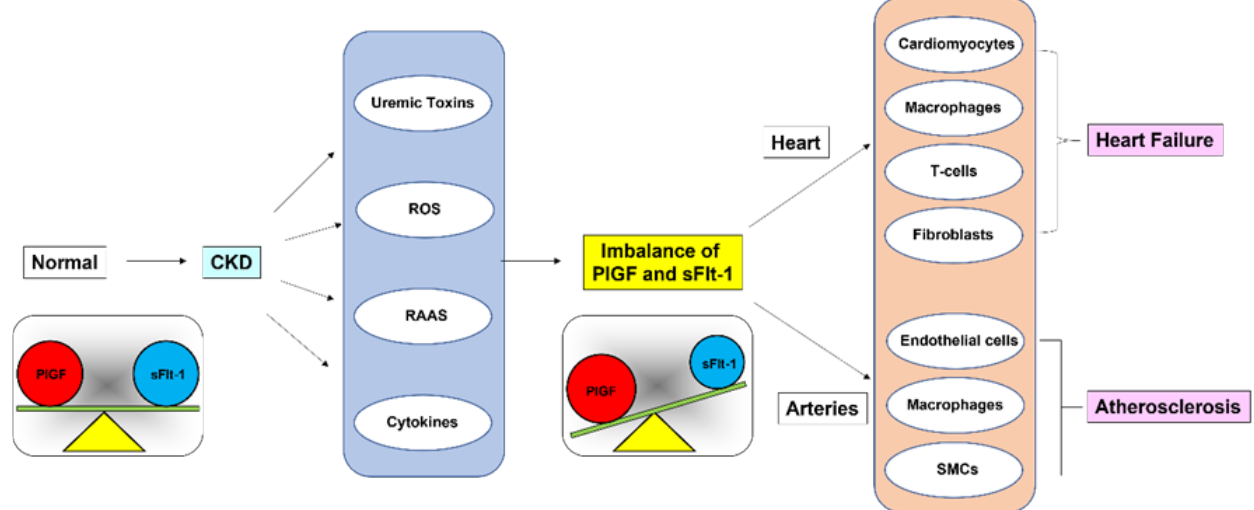
Figure 7. Imbalance between PlGF and sFlt-1 levels in CKD. Relative activation of PlGF/Flt-1 signaling, which is partly due to uremic toxins, exacerbates HF and contributes to plaque formation in large arteries in CKD.